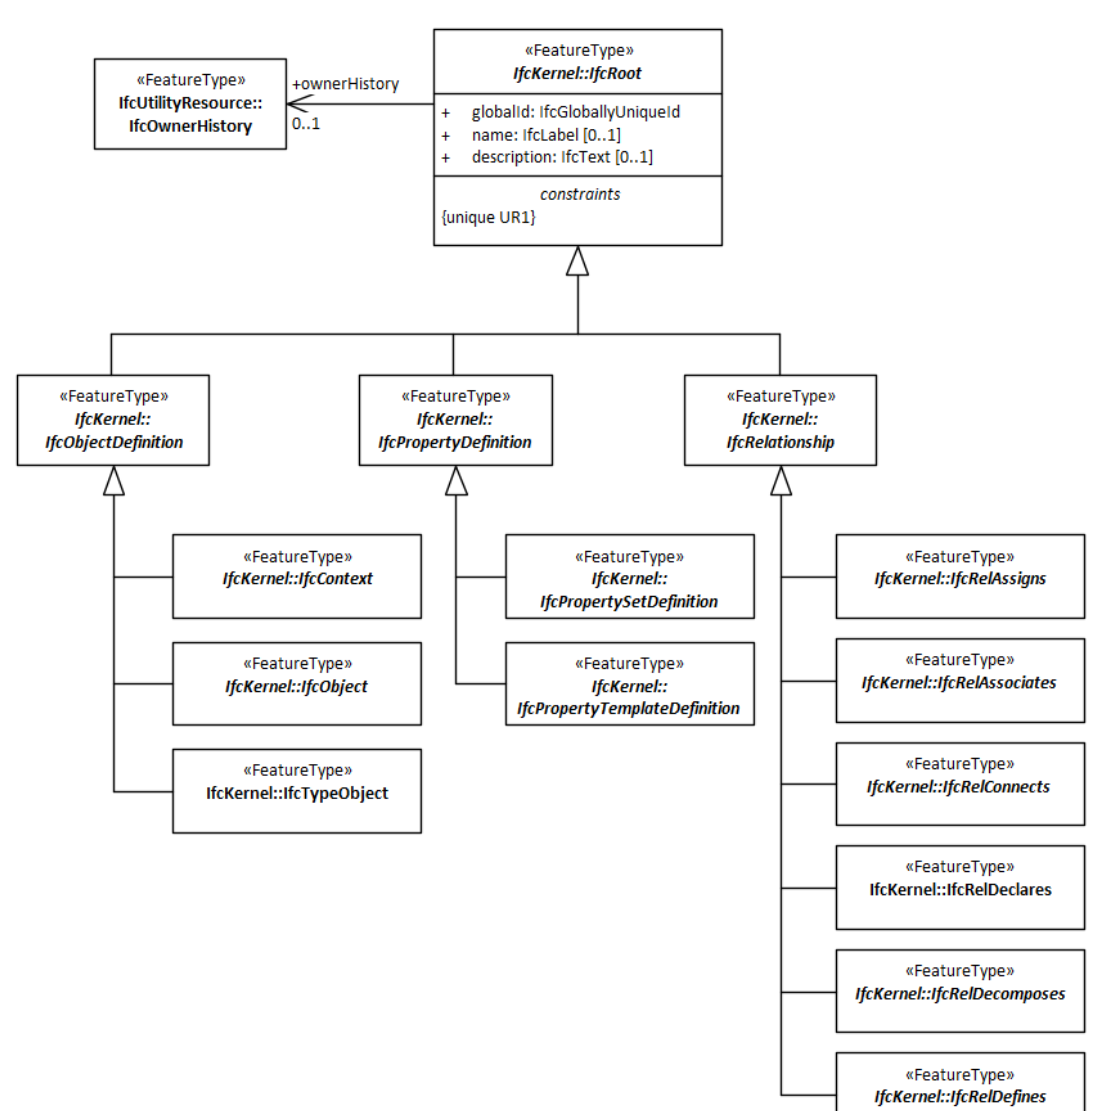
Figure 13. UML class diagram showing the IFC Kernel core classes.